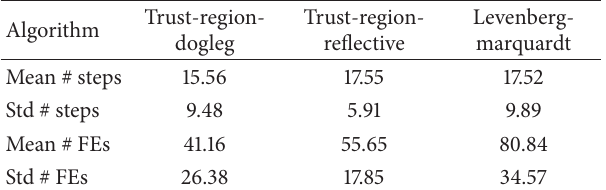
Figure9:Close-uparoundmaximumpowerpointofPower-Voltage curves at SRC of BP 3 235T, traced by using 3/4/5 parameter models.